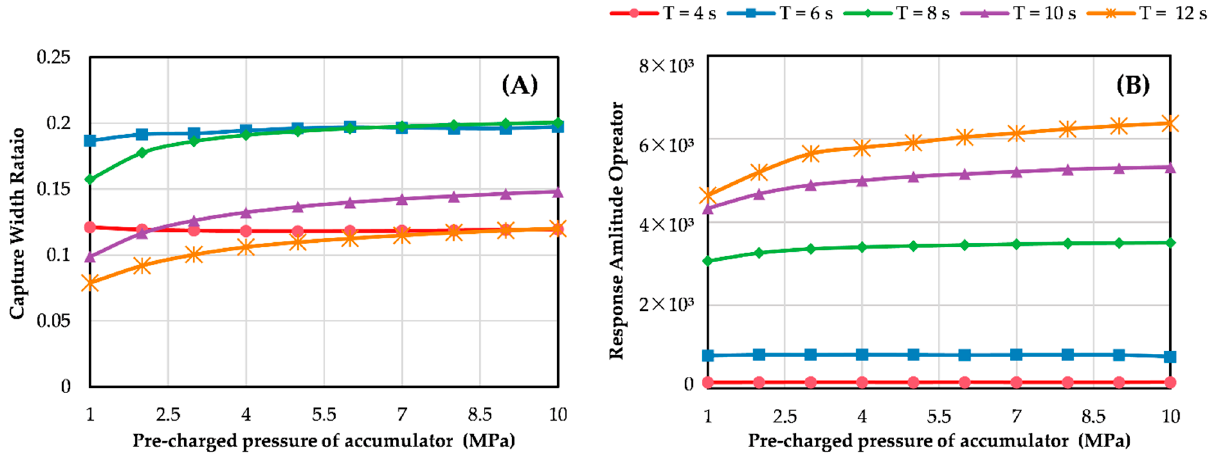
Figure 10. Influence of pre-charged pressure of accumulator on the performance of the hybrid system under wave height of 1.5 m. ( A ) Variation of CWR. ( B ) Variation of pitch motion RAO.